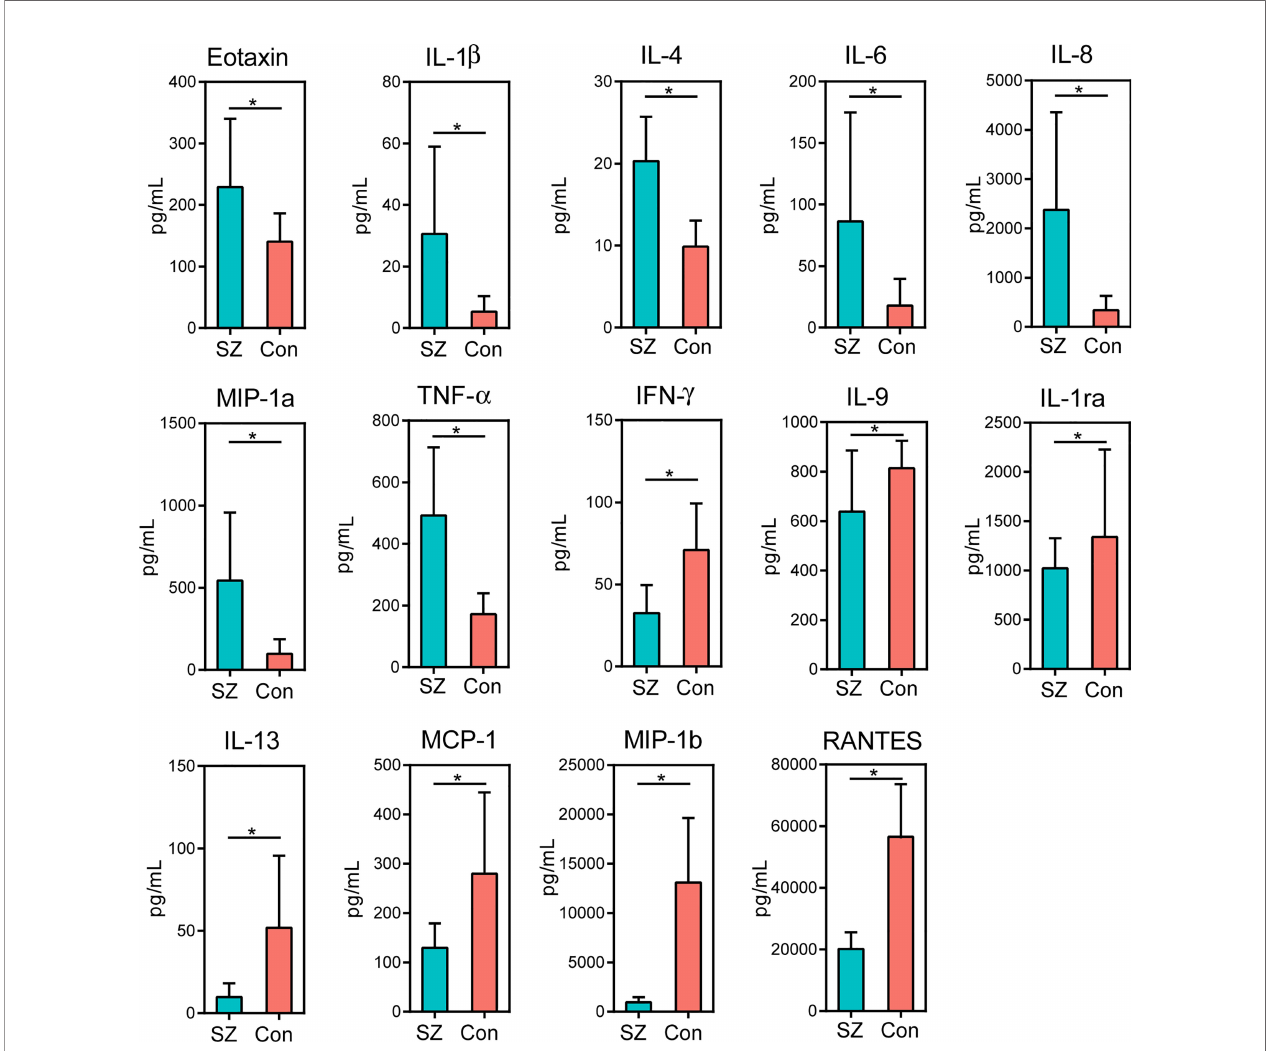
FIGURE 6 | Mean (SEM) concentrations (pg/ml) of 27 pro- and anti-in fl ammatory cytokines and chemokines in the elderly SZ patients and in healthy controls determined using Bio-Plex immunoassays. The concentrations of Eotaxin, IL-1 b , IL-4, IL-6, IL-8, MIP-1a and TNF- a increased signi fi cantly in the elderly SZ patients, while those of IFN- g , IL-9, IL-1ra, IL-13, MCP-1, MIP-1b and RANTES decreased signi fi cantly. *p <